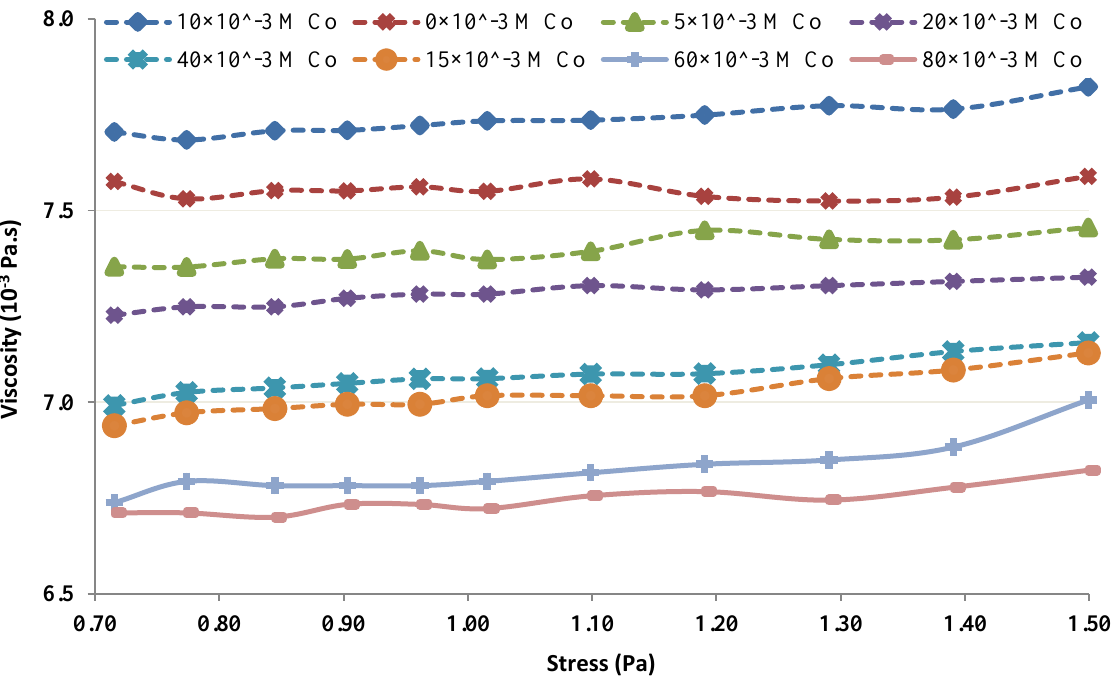
Figure 11. Rheological behavior of 6 g/L chitin.